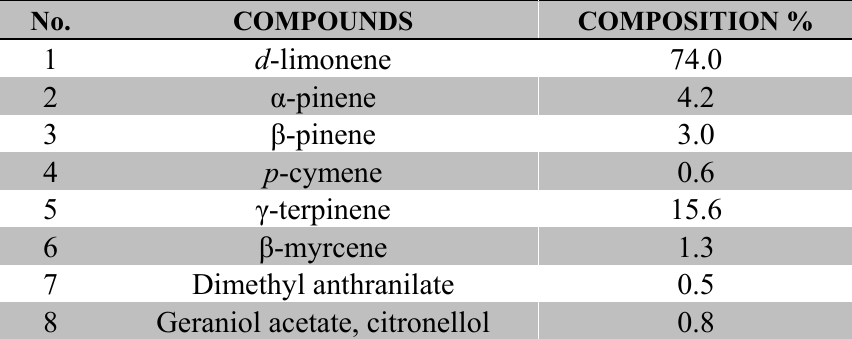
Table 1. Composition of the mandarin oil determined by GC/MS